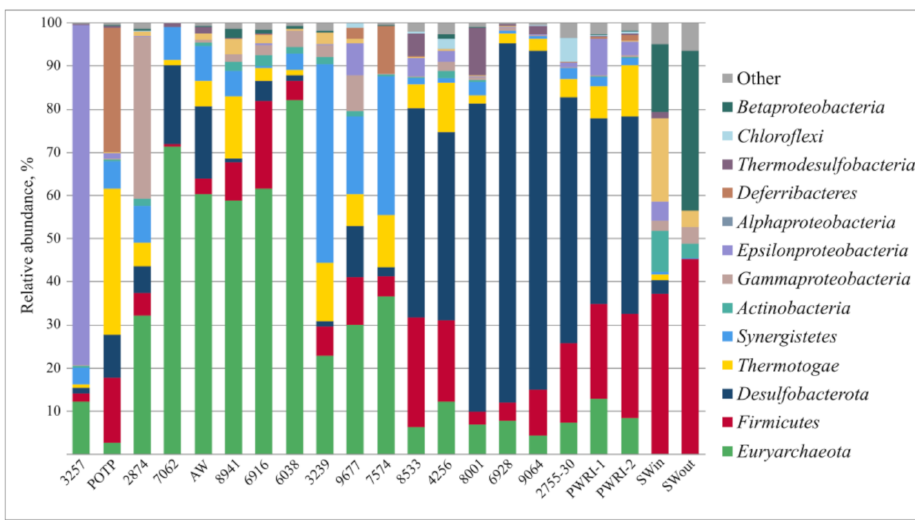
Figure 1. Taxonomic classification of archaeal and bacterial 16S rRNA gene fragments in the libraries from injection and production water samples from the Uzen oil field at the phylum level (at the class level for Proteobacteria ) using the RDP classifier. The taxa constituting at least >1% in each library are